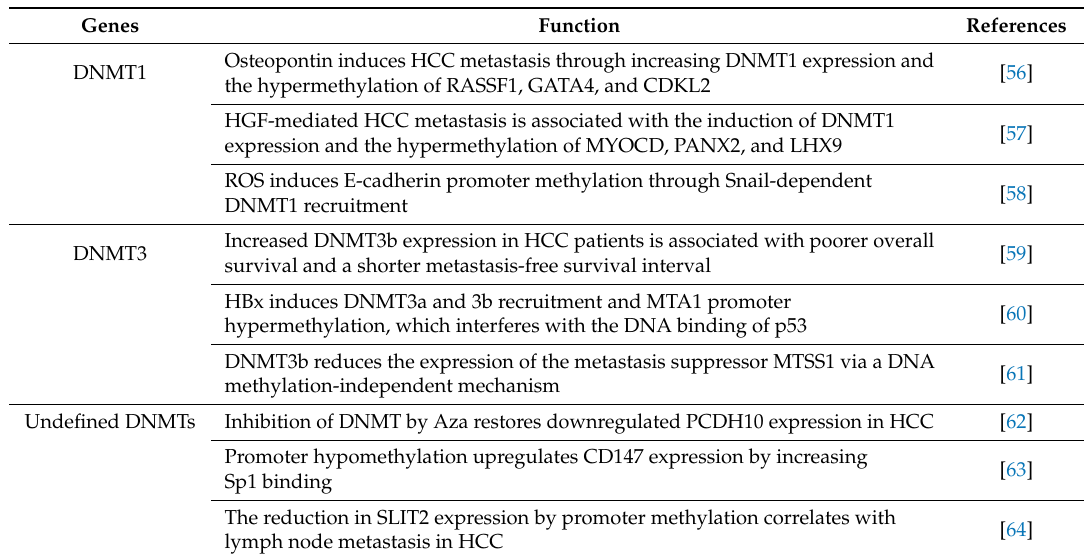
Table 2. DNA methyltransferases in HCC